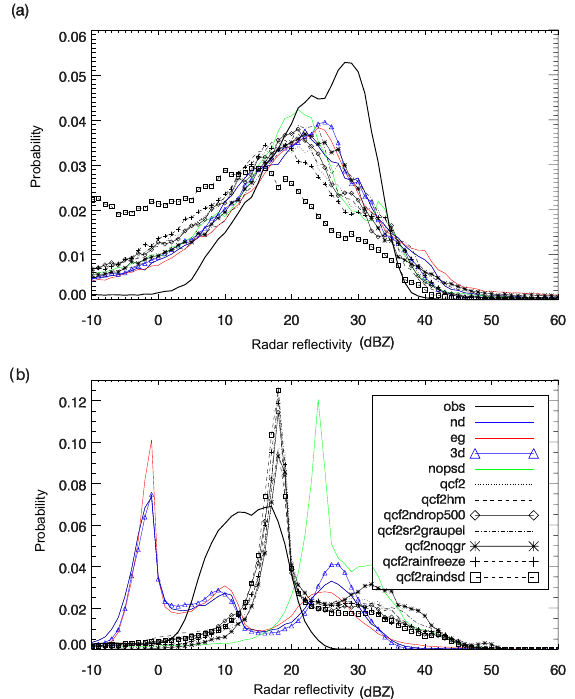
Figure 8. Radar reflectivity probability density functions for two heights, (a) 2.5 and (b)